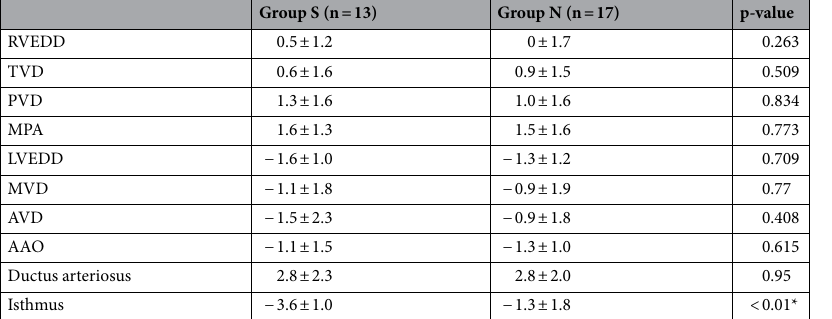
Table 2. Fetal echocardiographic dimensions Z-score compared between groups. RVEDD right ventricular end-diastolic diameter, LVEDD left ventricular end-diastolic diameter, TVD tricuspid valve diameter, MVD mitral valve diameter, MPA main pulmonary artery, AAO ascending aorta, PVD pulmonary valve diameter, AVD aortic valve diameter, DA index distal aortic arch index. * p < 0.05 between group S and group N.